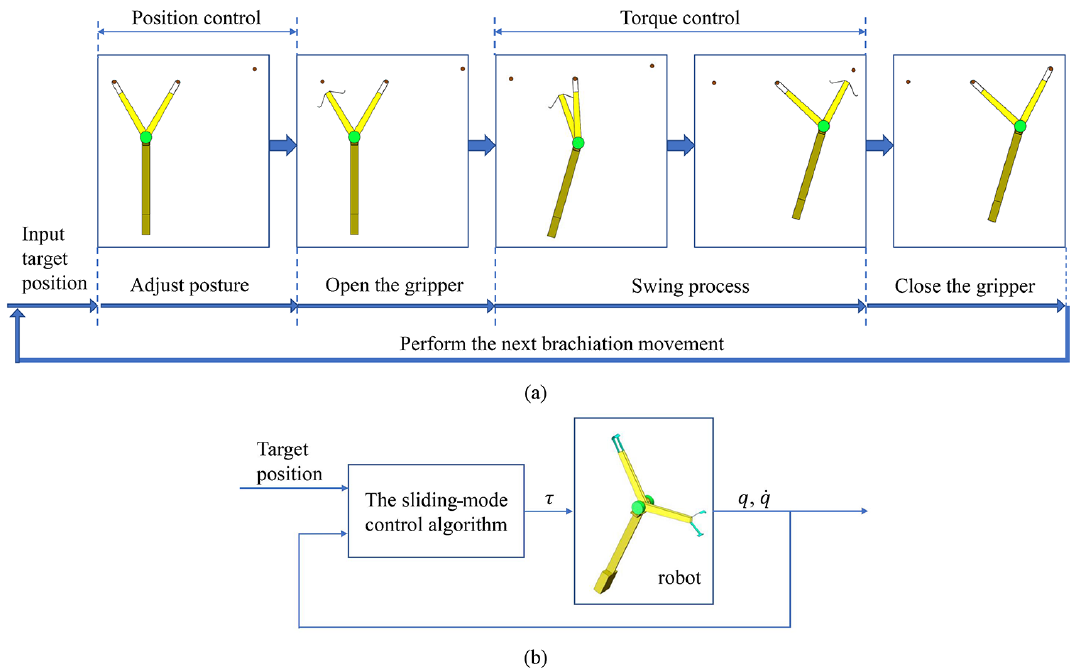
Figure 3. (a) Motion flow for continuous brachiation. (b) The control flow of the swing